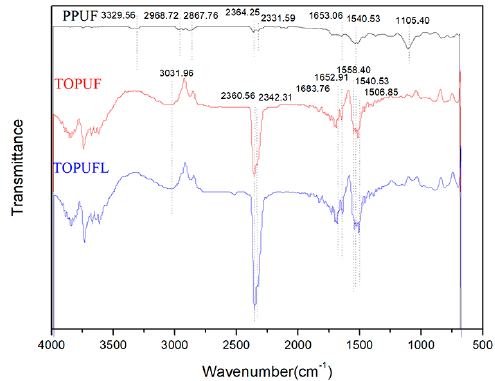
Figure 5. FTIR spectrums of different polyurethane foams.